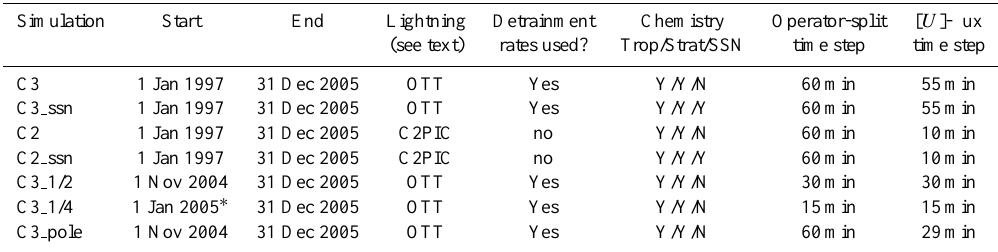
Table 2. Description of the full transport-chemistry simulations in this study. The notation C2 and C3 represents CTM2 and CTM3, respec- tively. Lightning parameterizations are described in Sect. 2.6 The [ U ]-wind time step annual average for year 2005. “SSN” denotes “sea salt, sulfate and nitrate”. ∗ C3 1/4 was started from C3 1/2 at 1 Jan 2005. Simulation Start End Lightning Detrainment Chemistry Operator-split [ U ]-flux (see text) rates used? Trop/Strat/SSN time step time step C3